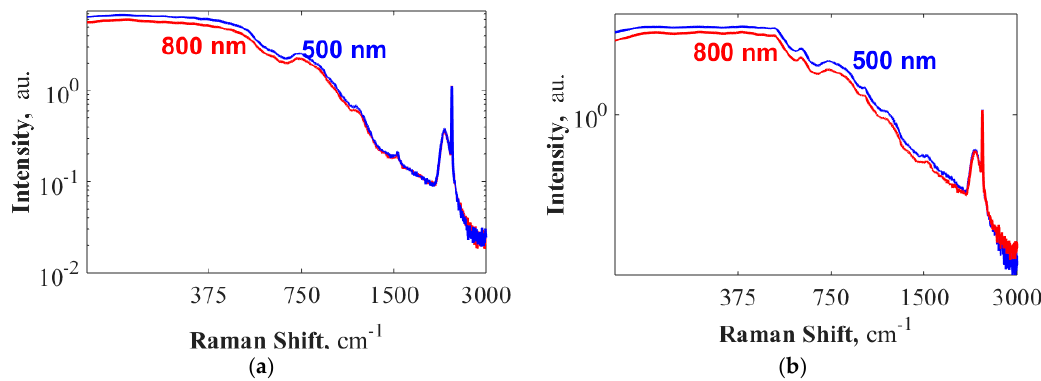
Figure 3. Difference in the spectra of the WGBL when normalized with the peak at 2330 cm − 1 originating from the core. Excitation and collection for ( a ) TE polarization; and ( b ) Quasi-transverse-magnetic (TM) polarization using waveguide of widths w = 500 nm and w = 800 nm. A minor difference in the amplitude of the spectra (maximum: 0.8 dB) is observed.